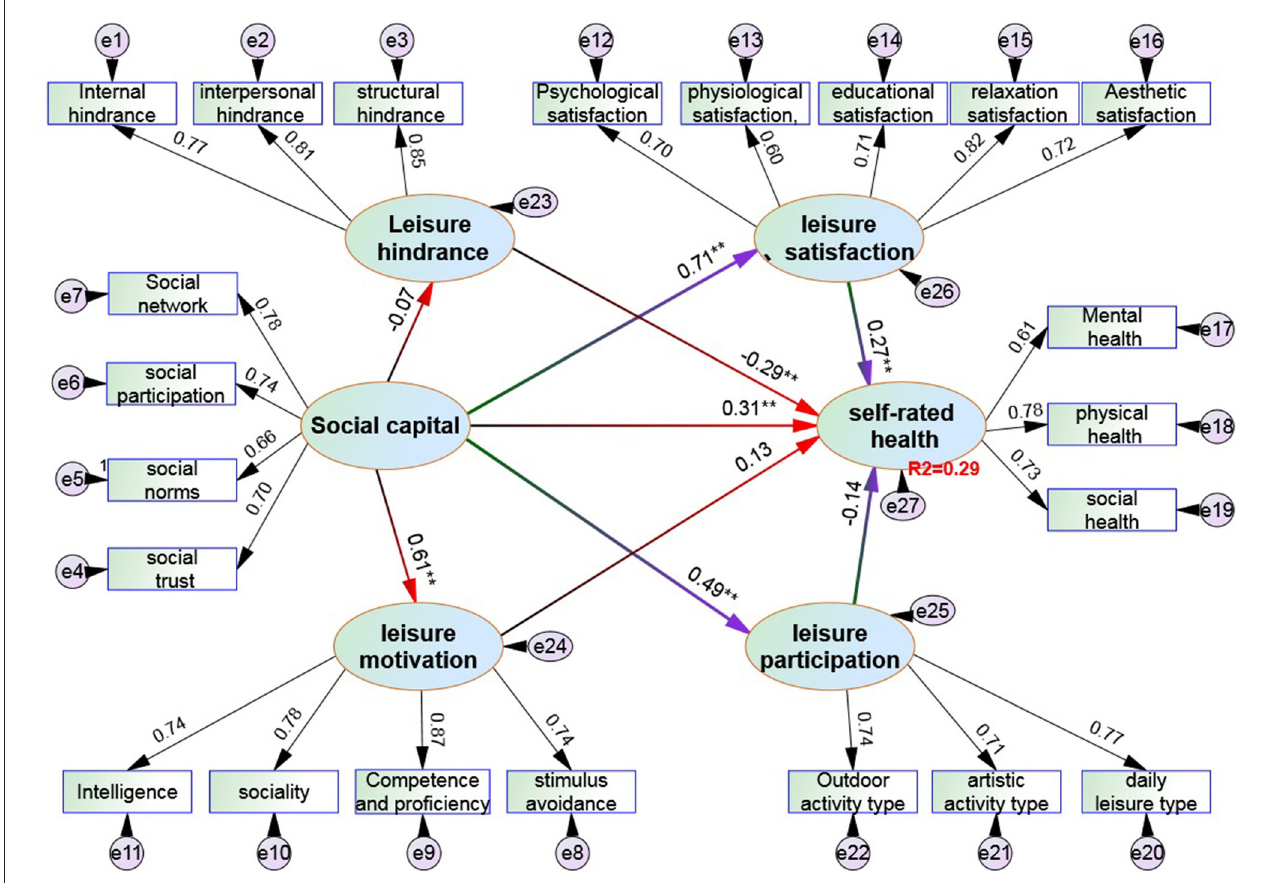
FIGURE 2 | Structural equation model verification of the impact of social capital and leisure behavior on self-rated health. “* , **, and ***” represent the significant levels of 0.05, 0.01, and 0.001,